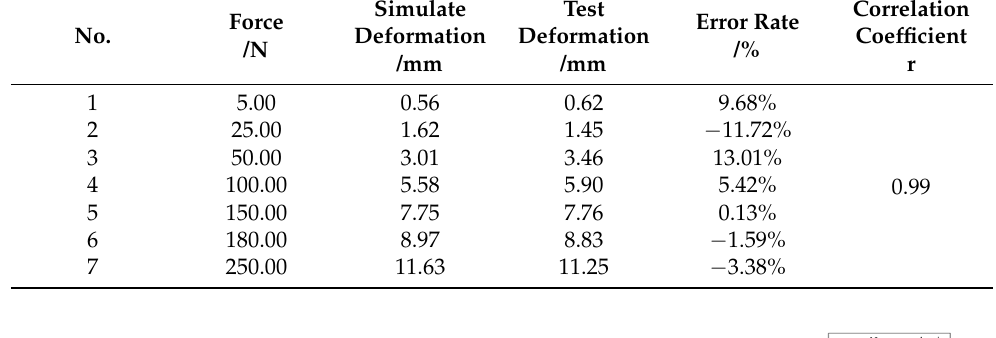
Table 4. Comparative analysis of the compression test and simulation test. Simulate Force Deformation No. /N /mm After standing for 24 h, the near − infrared spectrum of the kiwifruit was detected, as shown in Figure 8, and there were different degrees of gap in the spectral lines of the kiwifruit fruits above 25 N. The spectral lines at the stressed and non − stressed points had a very obvious shift, and the greater the force, the more obvious the shift. This indicates that invisible damage existed inside the kiwifruit.